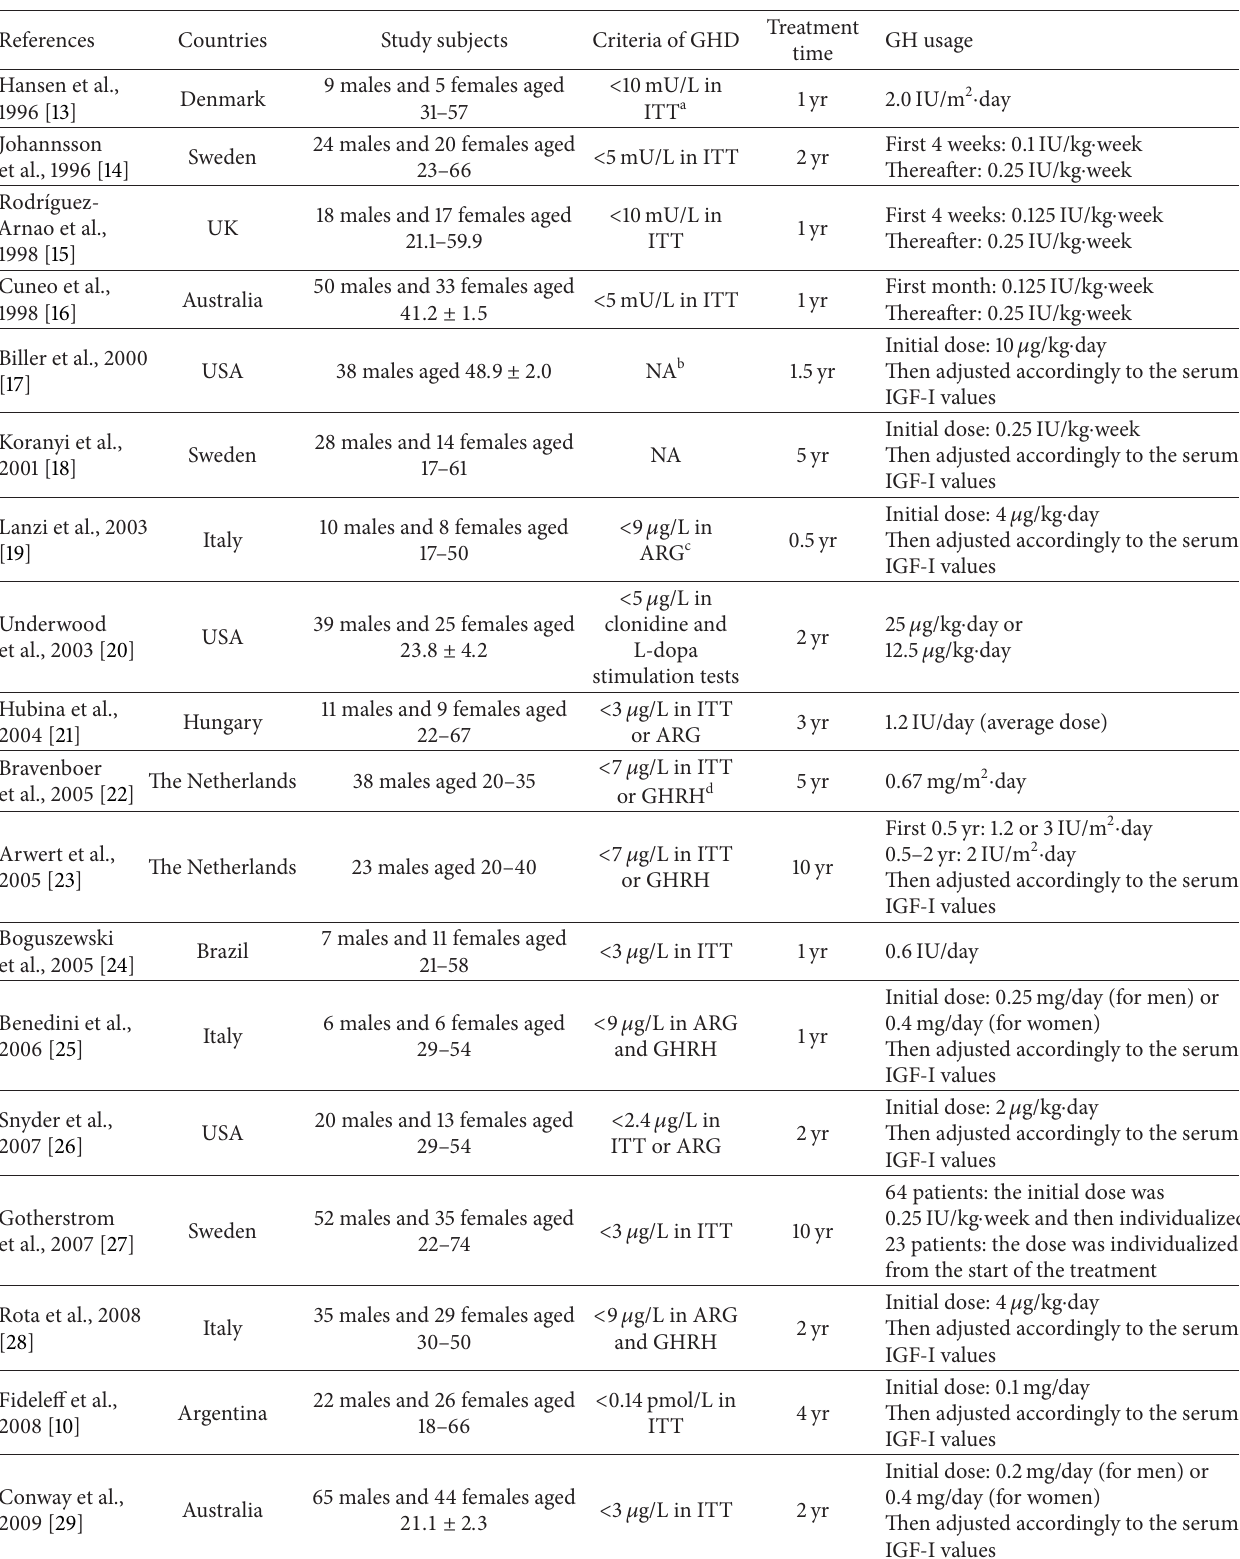
Table 1: Patient characteristics in included